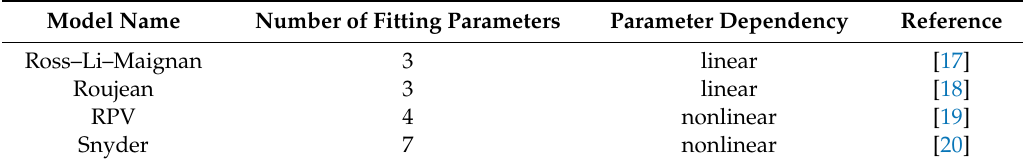
Table 3. List of the BRDF models and their